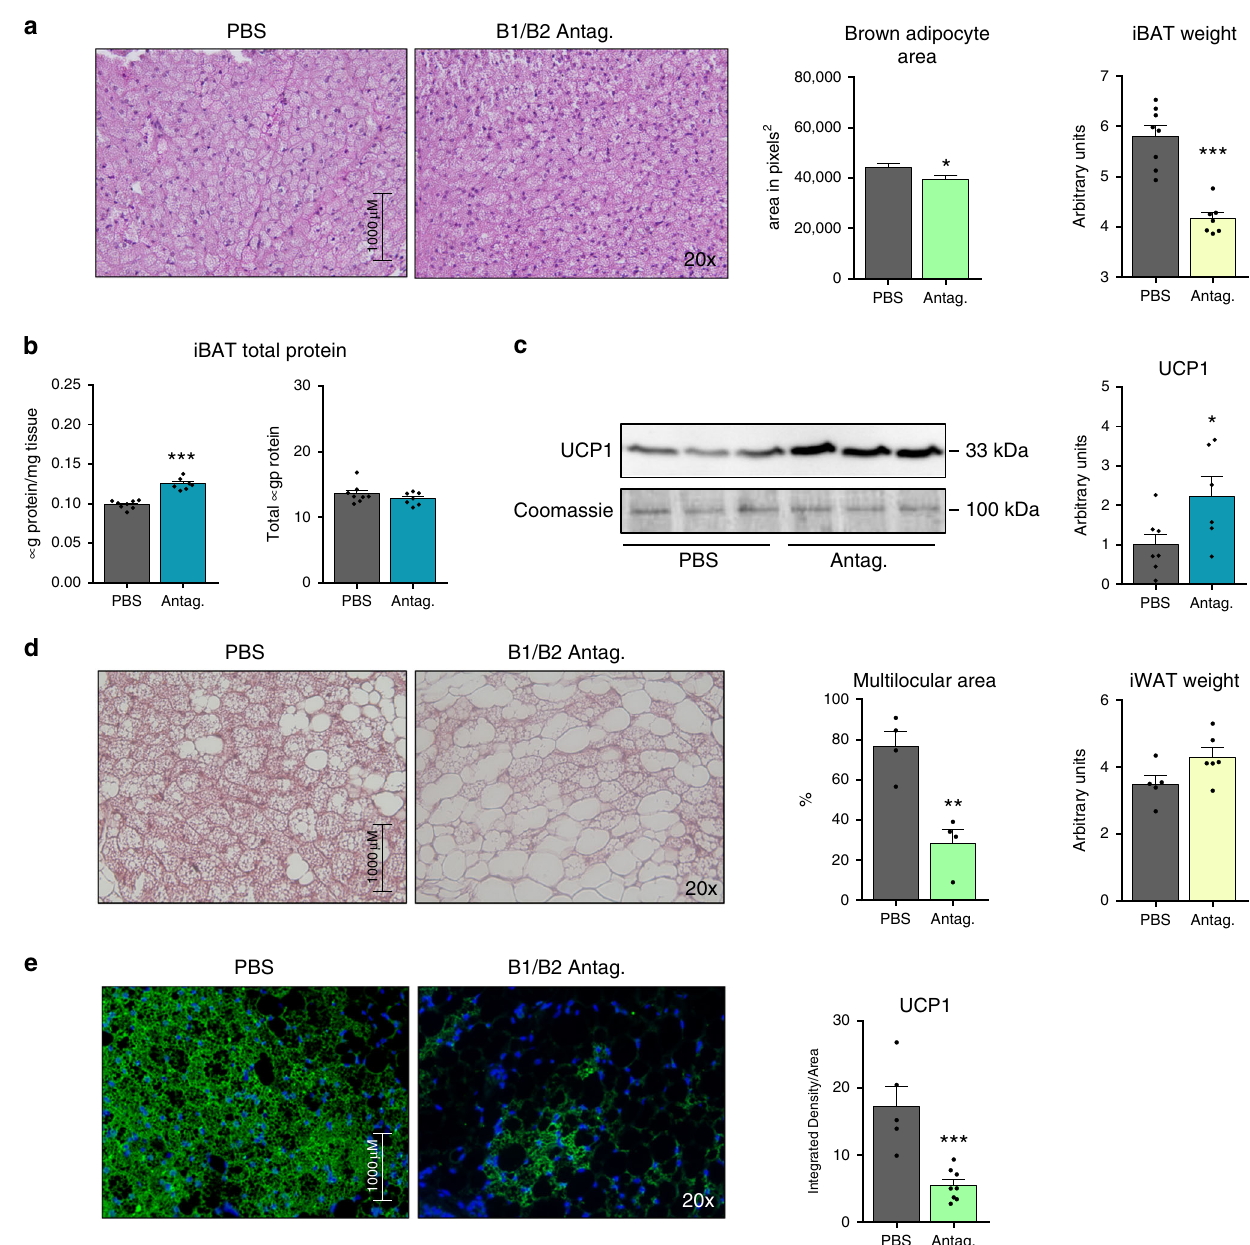
Fig. 5 Effects of local pharmacological inhibition of B1/B2 receptors at iBAT and iWAT. a H&E-stained iBAT histological sections and quanti fi cation (at least 3 different pictures) of cell size in 2 months old WT C57BL/6J mice exposed to 4 °C for 1 week and then implanted in the back with mini-pumps delivering either PBS or a cocktail of B1 and B2 antagonists; iBAT weight normalized to tibia length ( n = 8 animals for PBS and n = 7 animals